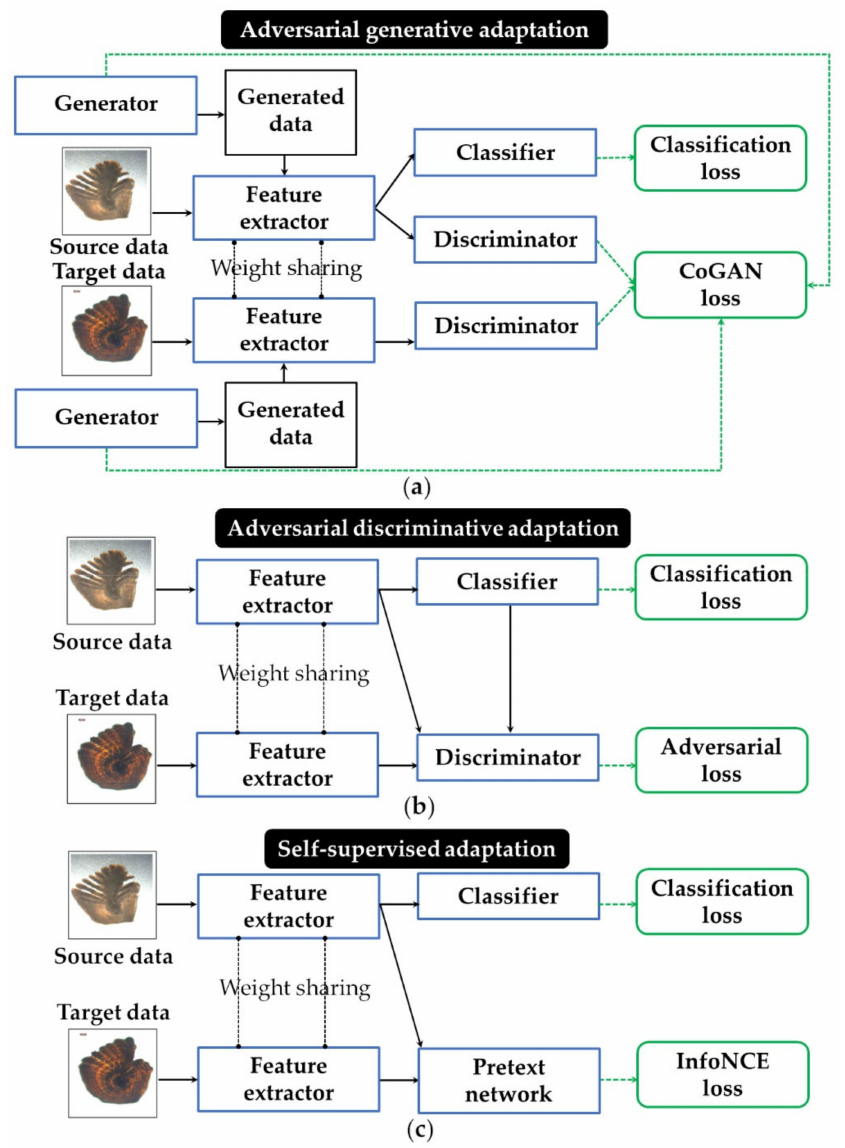
Figure 3. Illustration of the different UDA architectures utilized for automatic age determina- tion of otoliths across Norwegian (source) and Icelandic (target) labs. ( a ) Adversarial genera- tive adaptation (CoGAN); ( b ) Adversarial discriminative adaptation (CDAN); ( c ) Self-supervised adaptation